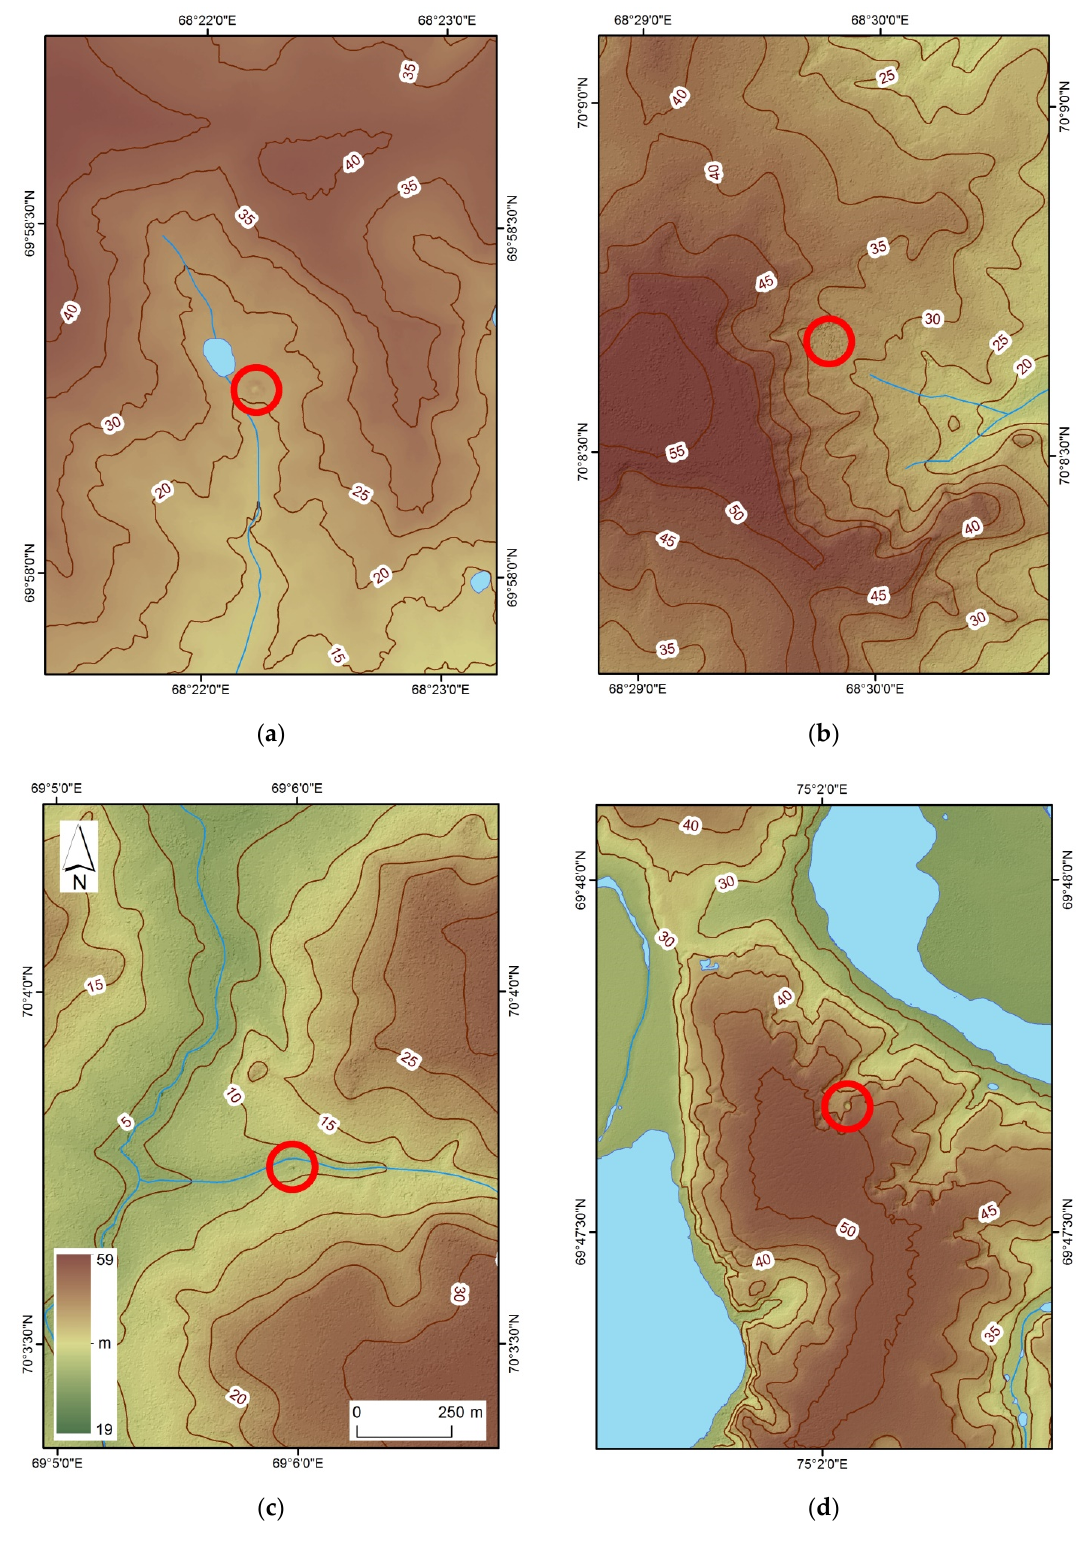
Figure 2. Differences in the geomorphic setting of gas emission craters identified through DSM analysis. Key site DSM fragments: ( a ) GEC-1, ( b ) GEC-2, ( c ) GEC-3, ( d ) AntGEC. Red circles indicate GEC location. GEC